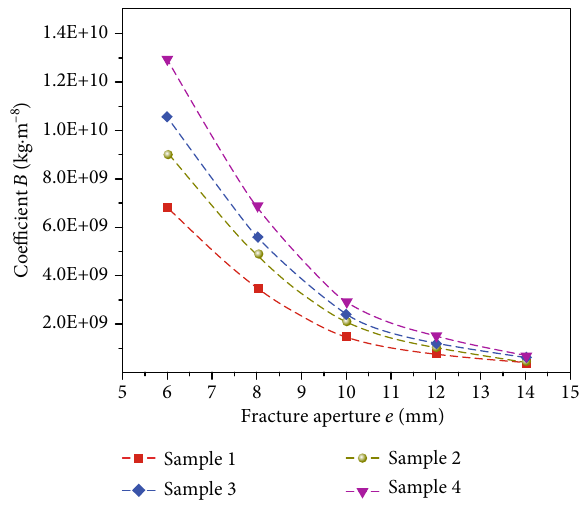
Figure 14: Variation of coe ffi cient B with fracture apertures.